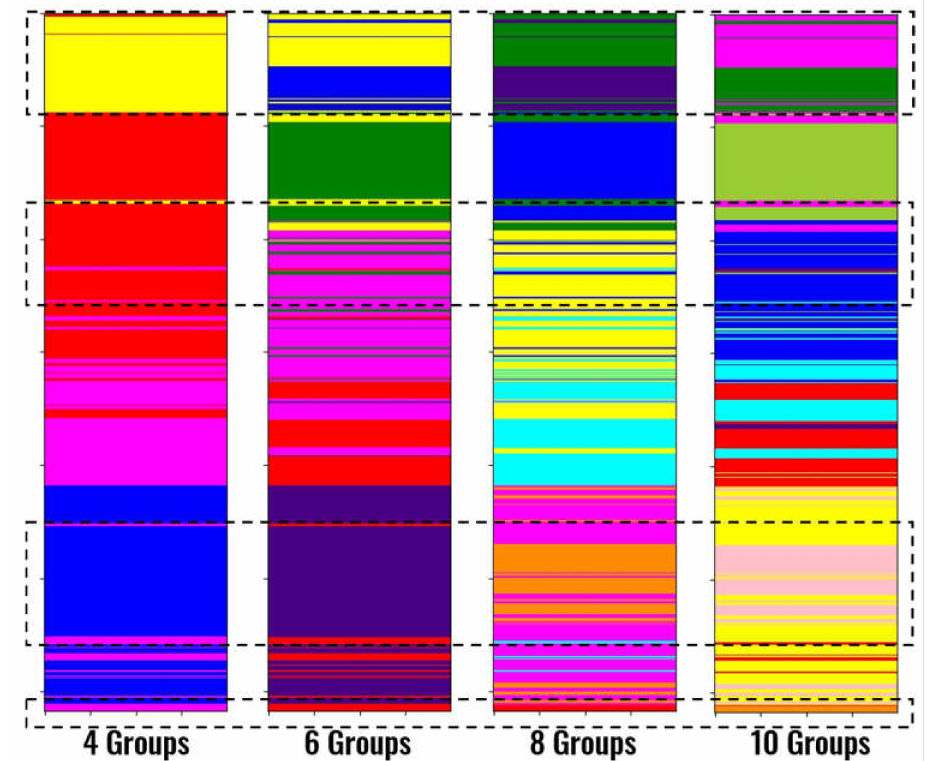
Figure 20. Results for different number of groups in k-Means for a window of 6 m.